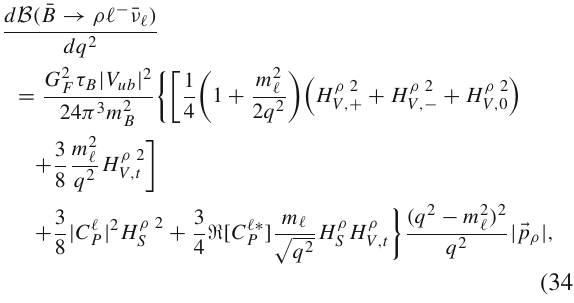
Fig. 5 Constraints in the | C whereas in the right panel the roles of φ